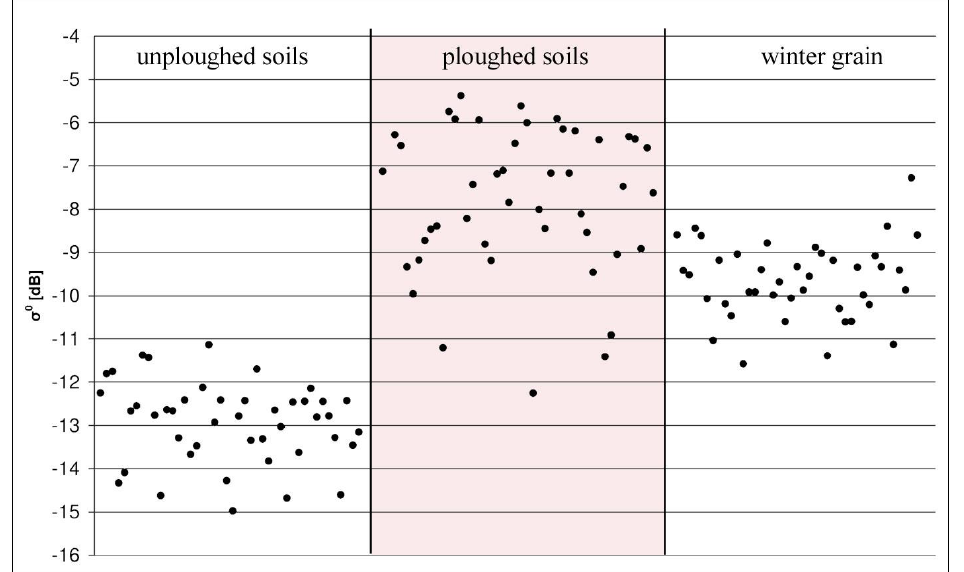
Figure 5. Mean backscatter values per field in March 2009 for VV polarization in the Fuhrberg